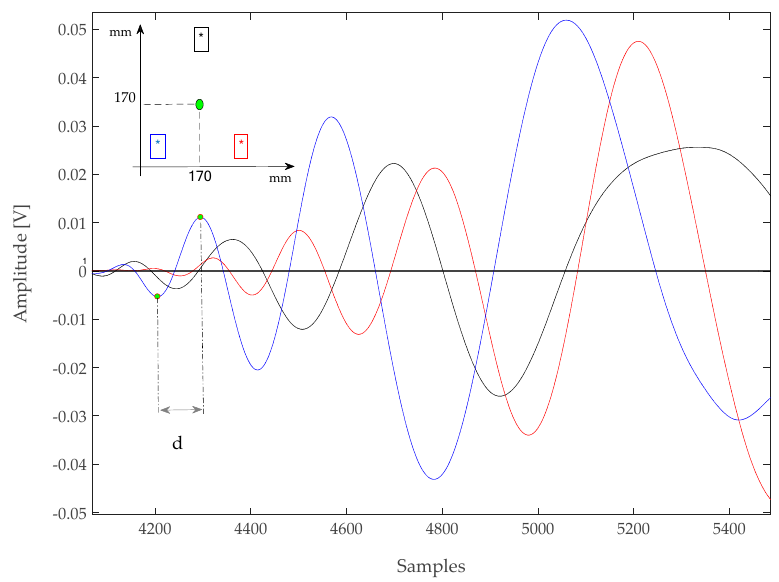
Figure 6. Signal acquired with type A sensors after an impact at (170, 170) mm. Sampling rate 10 MSps. The interval between a previous minimum and the successive maximum of a zero-crossing is marked with “ d ” in the plot.